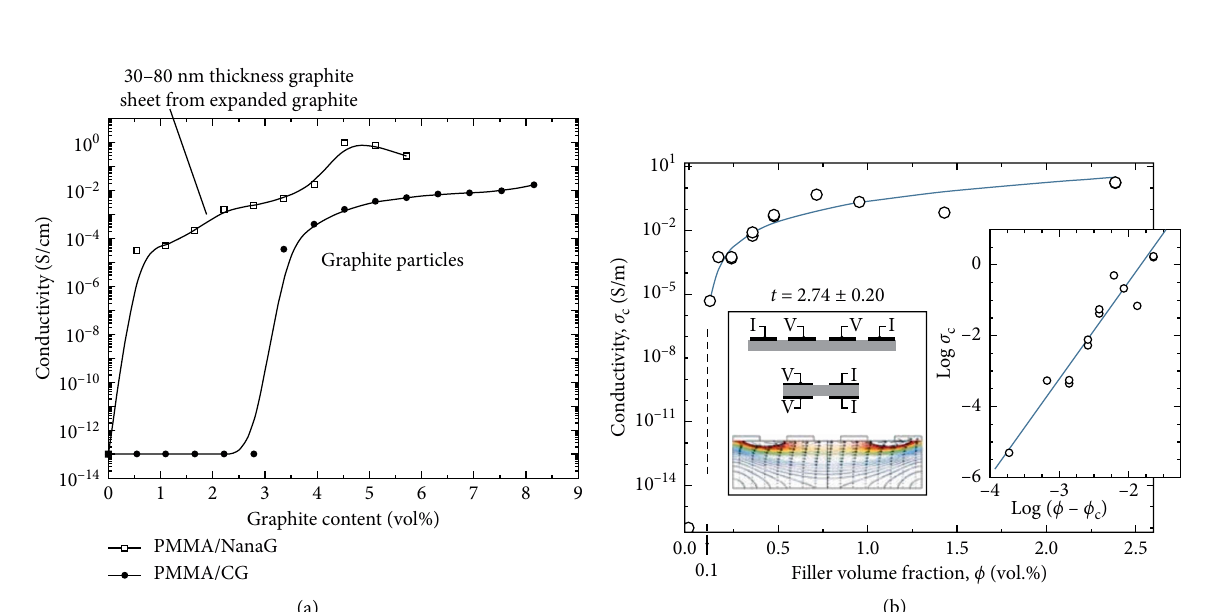
Figure 2: (a) Electrical conductivity of polymethyl methacrylate (PMMA)/graphite with different graphite contents. Adapted from [74]. (b) Electrical conductivity of polystyrene/graphene with different filler volume fractions. Adapted from